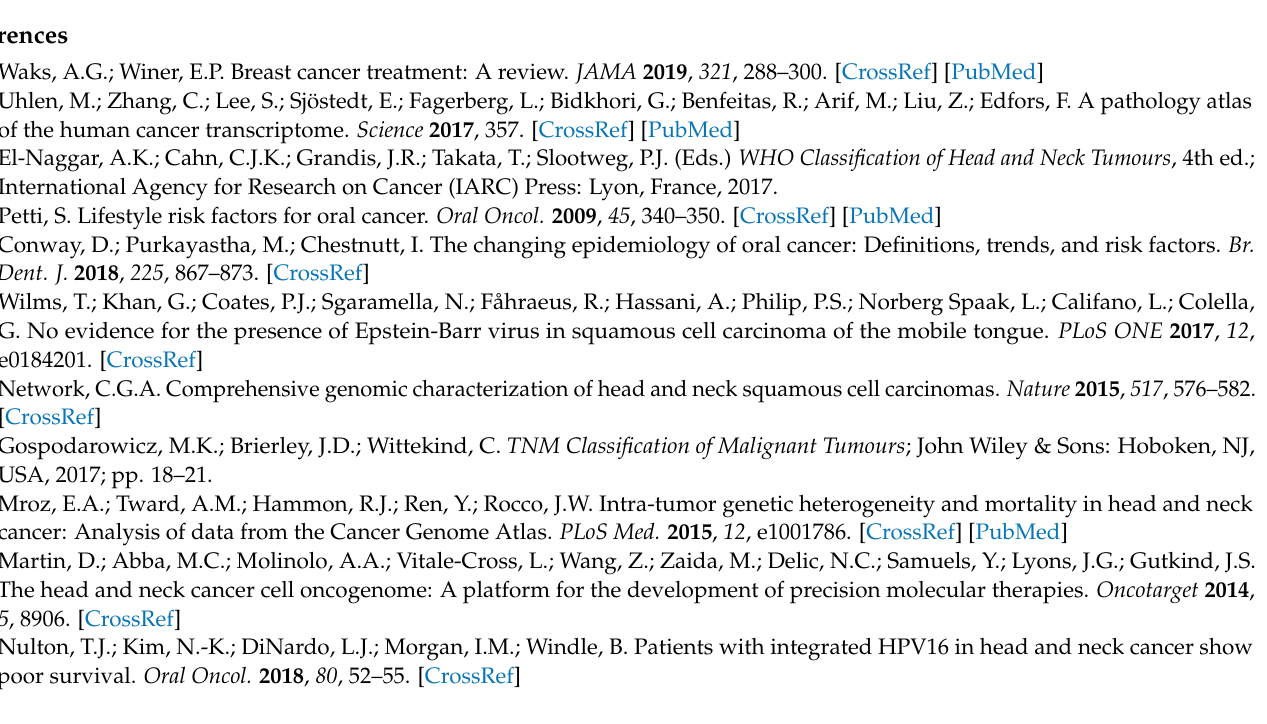
Figure S3: Log minus log plots for proportional hazards checking. Table S1: Reasoning behind selection of prognostic markers for Head and neck cancer in the Pathology Atlas to validate in a cohort of oral tongue